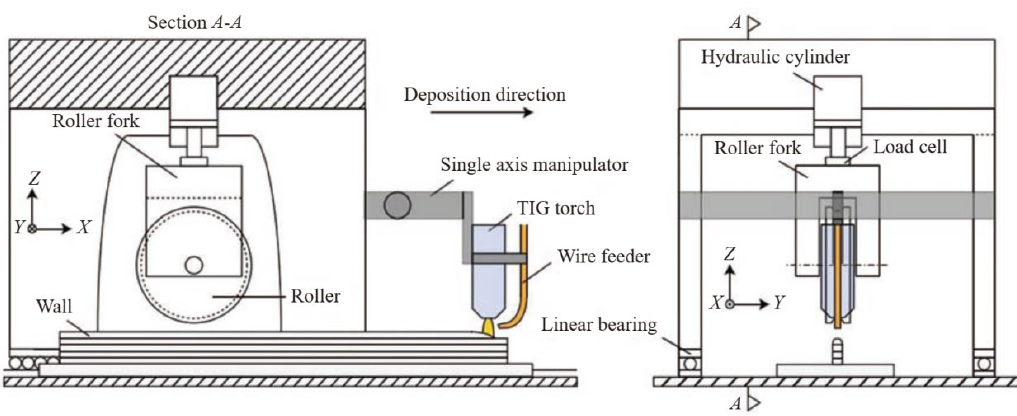
Figure 17. Schematic diagram of cold rolling deformation and arc additive manufacturing technology.